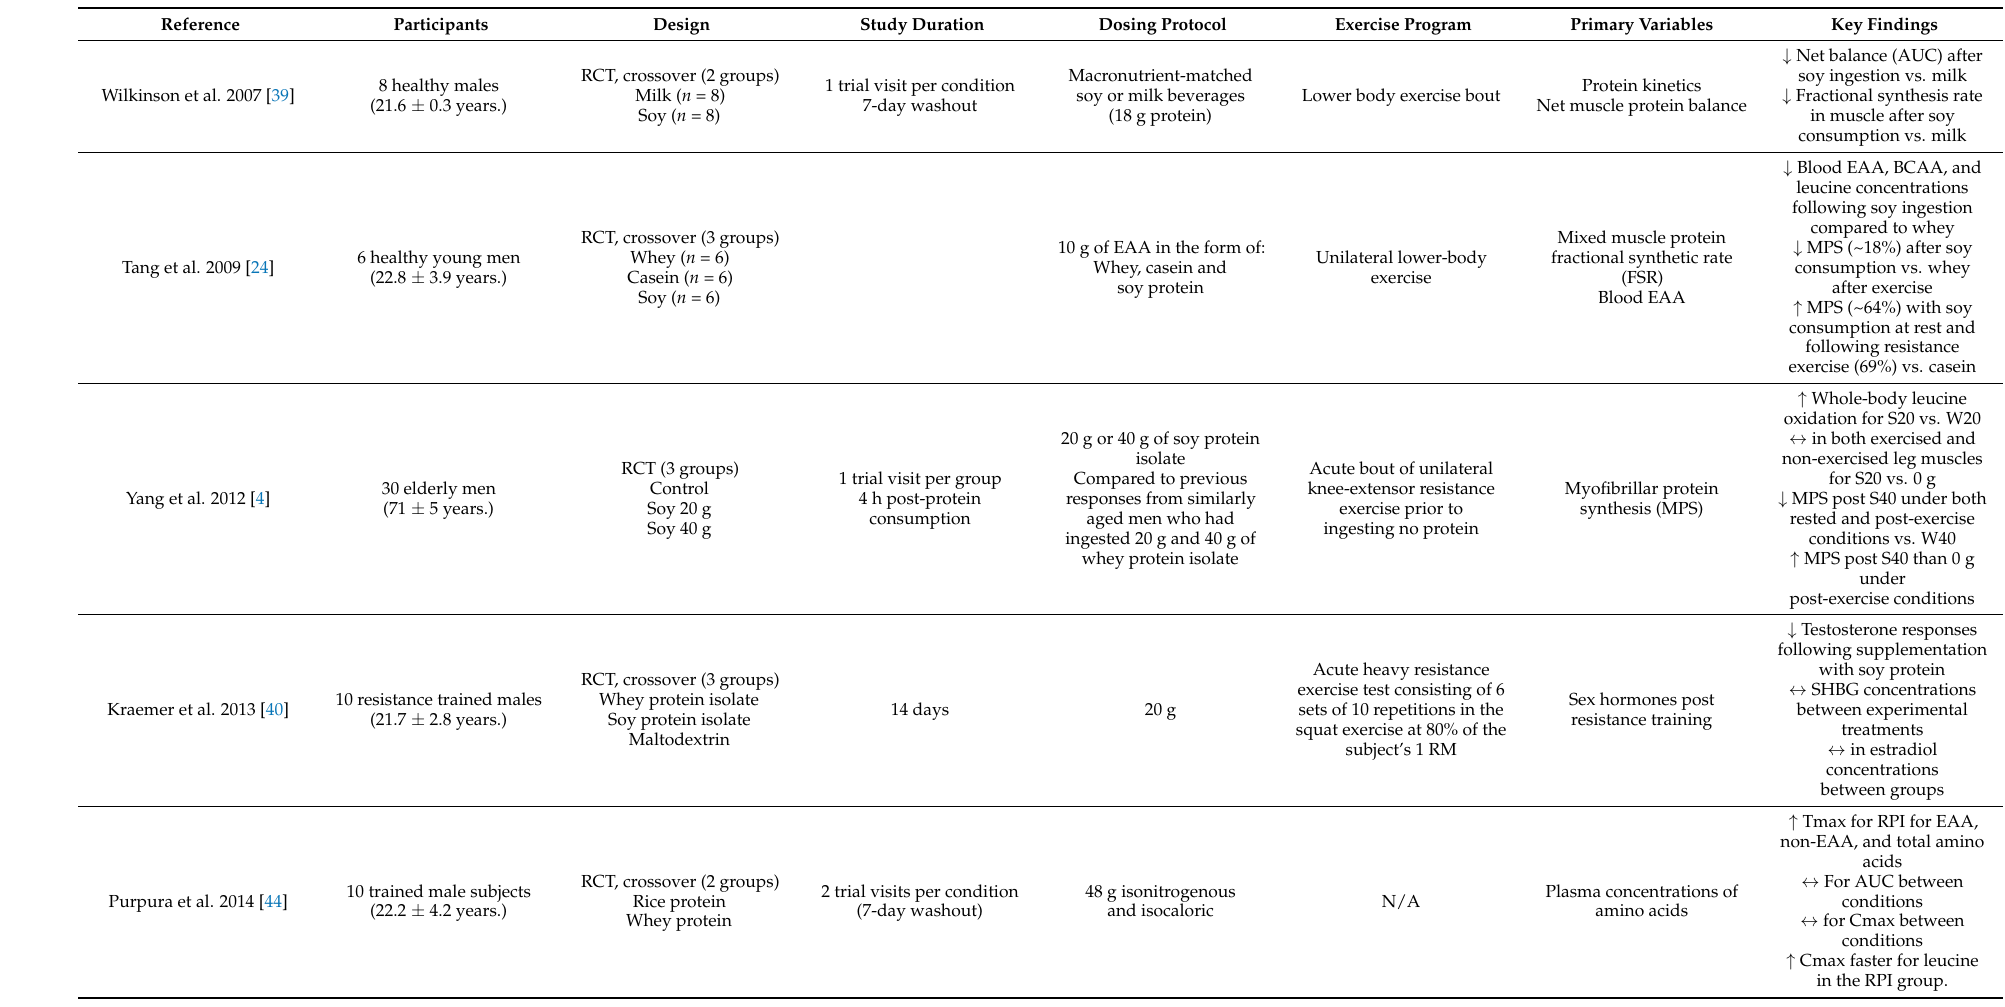
Table 1. Summary Table of Acute Responses to Plant Protein